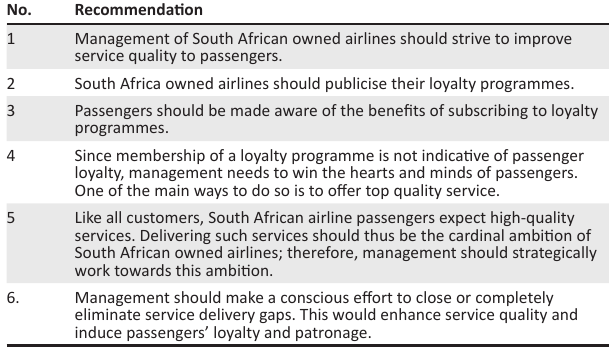
TABLE 9: Summary of recommendations.